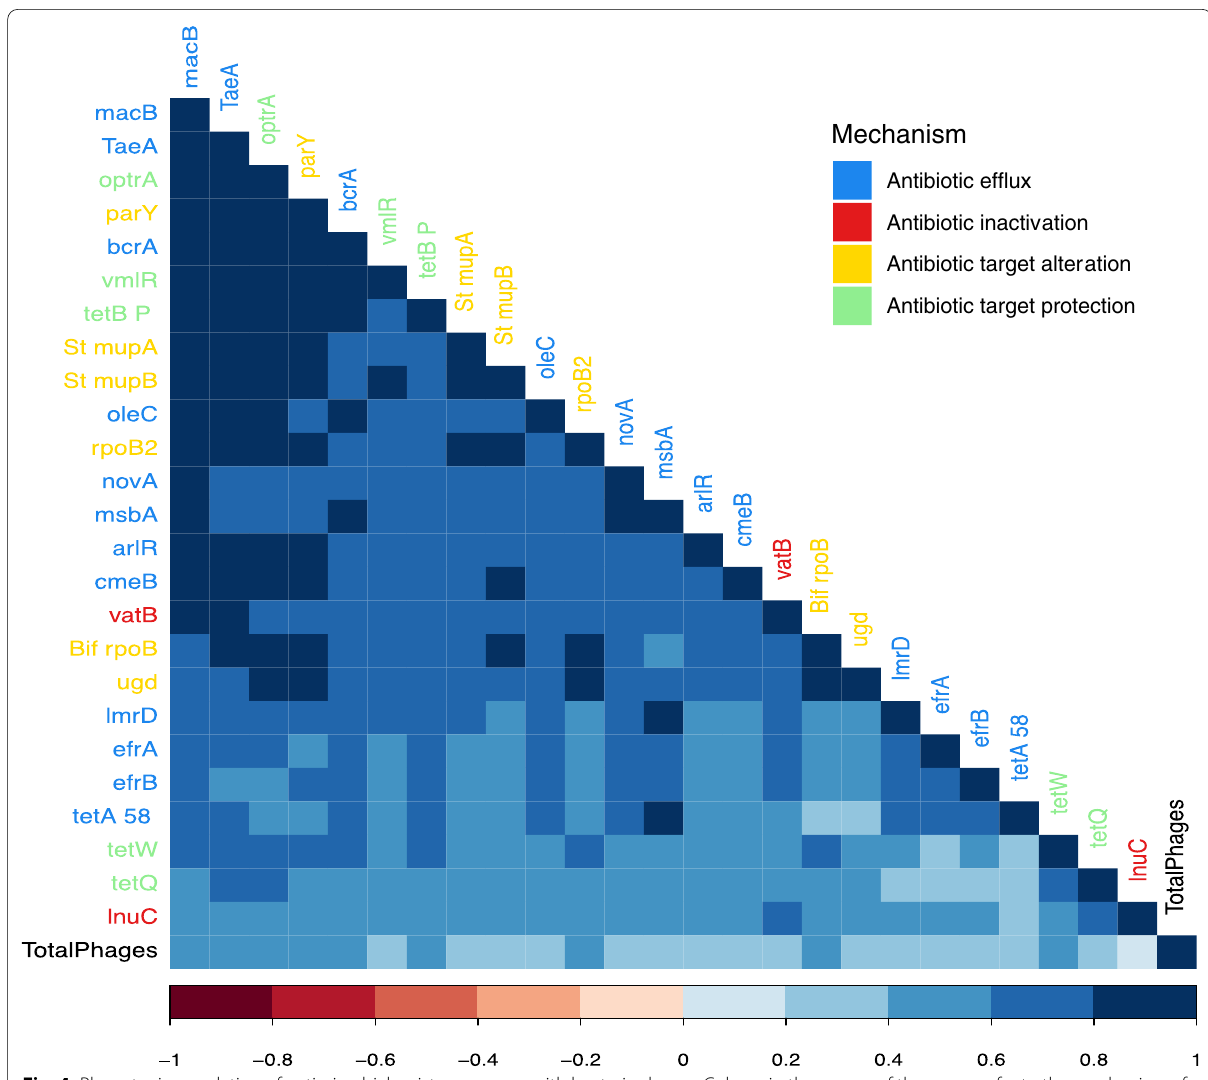
Fig. 4 Phenotypic correlation of antimicrobial resistance genes with bacteriophages. Colours in the names of the genes refer to the mechanism of